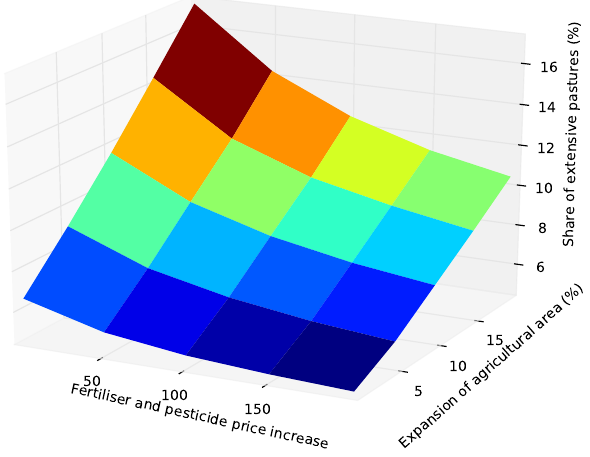
Fig. 15. Variations of the proportion of extensive pastures in func- tion of chemical inputs price and expansion rate of agricultural lands between 2001 and